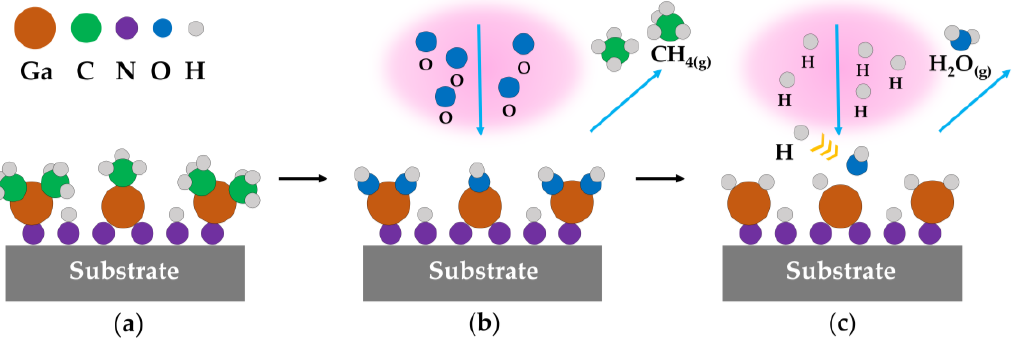
Figure 5. A schematic diagram of the mechanism described in Equations (6) and (7). ( a ) the surface of films after 1st half reaction, ( b ) oxygen radicals oxidize Ŝ -(N-Ga(CH 3 ) 3-x ) x , ( c ) Ga-OH bond dissociation via hydrogen radicals.